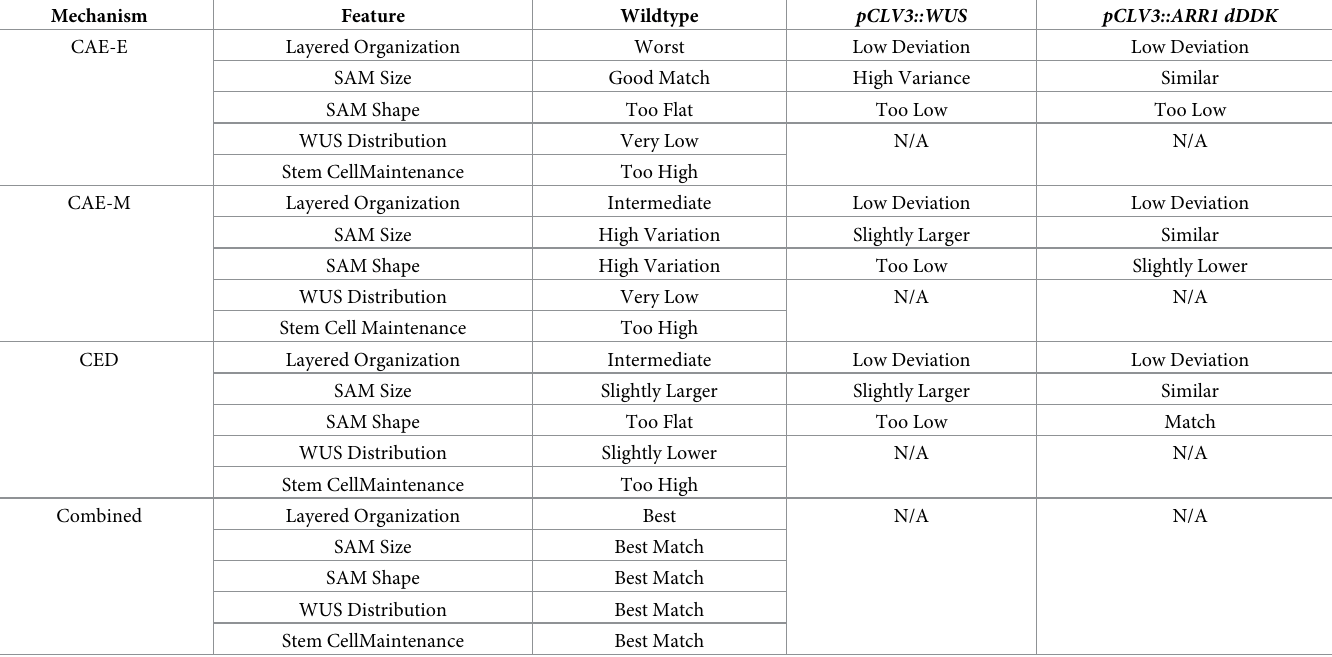
Table 2. Summary of tissue-level features resulting from the testing of four hypothesized mechanisms of regulation compared to experiments.